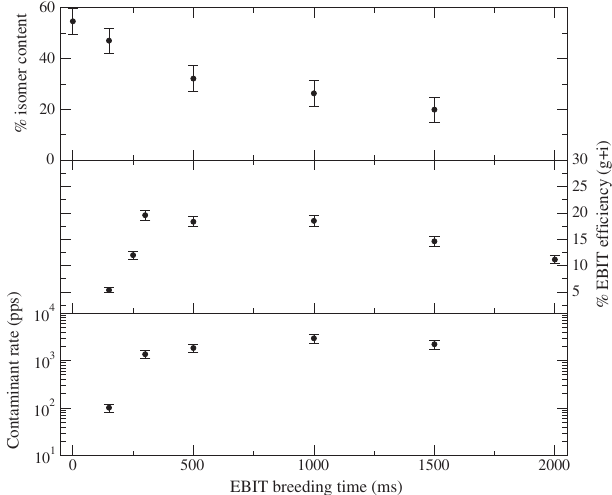
FIG. 4. Top panel: Isomer content as a percent of the total 38 K rate for different breeding times of the EBIT. The changing ratio follows the general trend dictated by the two different lifetimes, but additional losses such as ions escaping the EBIT trapping potentials during the charge breeding process can be observed. A breeding time of “ zero ” represents the starting isomer percentage prior to breeding; this ignores the additional decay time spent during accumulation in the cooler buncher. Middle panel: Percent efficiency for extracting the total 38 K beam (ground state plus isomer) from the EBIT. Bottom panel: Rate of contaminants, mostly stable 38 Ar from the EBIT residual gas, extracted from the EBIT for the different breeding